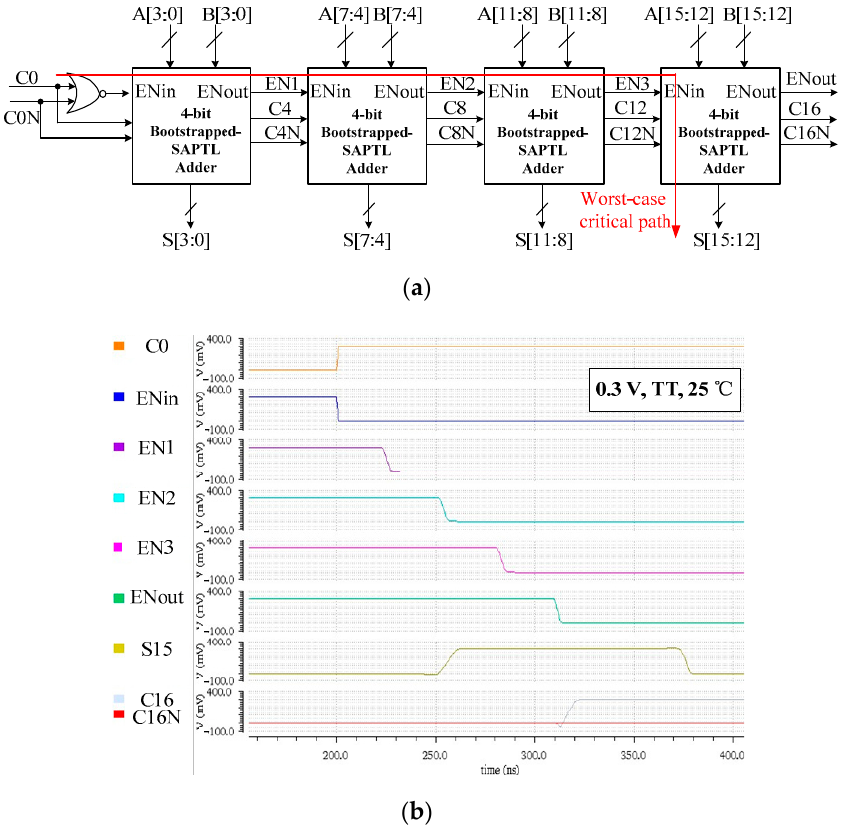
Figure 7. The proposed 16 bit adder: ( a ) block diagram; ( b ) transient simulated waveform.